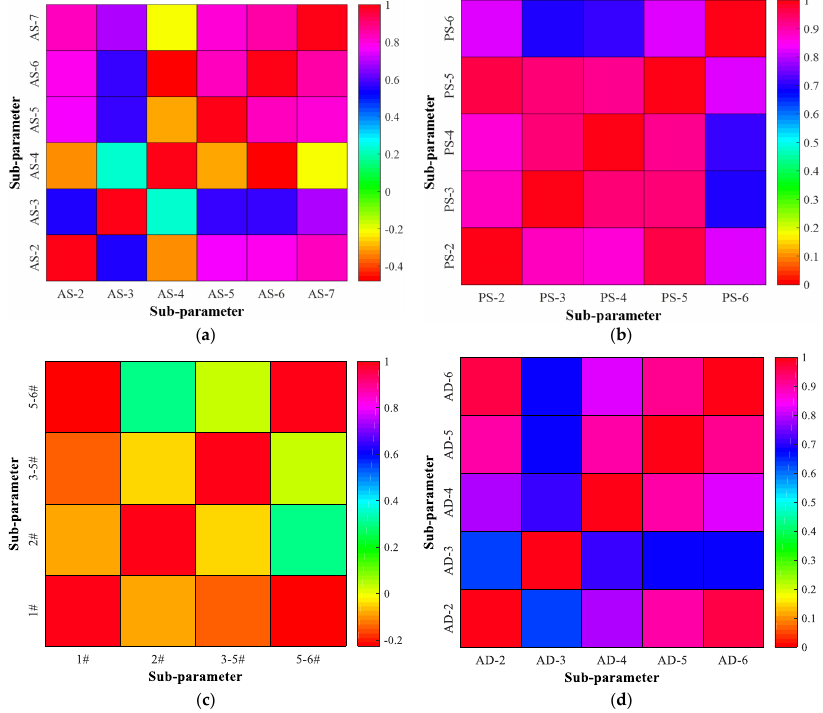
Figure 11. Correlation coefficient between monitoring sub-parameters. ( a ) Arch strain. ( b ) Pier strain. ( c ) Crack width of deck beam. ( d ) Arch displacement. For the CFST arch bridge case, the key sub-parameters for the arch strains, pier strains, crack widths of deck beams, and arch displacements are ‘ AS-4 ’ , ‘ PS-6 ’ , ‘ 1# ’ , and ‘ AD-3 ’ , respectively, by adopting the PCA and EW method, see Table 10. A satisfactory agreement is found when comparing results by two methods. Table 10. Key measuring point selection for multivariable parameters.